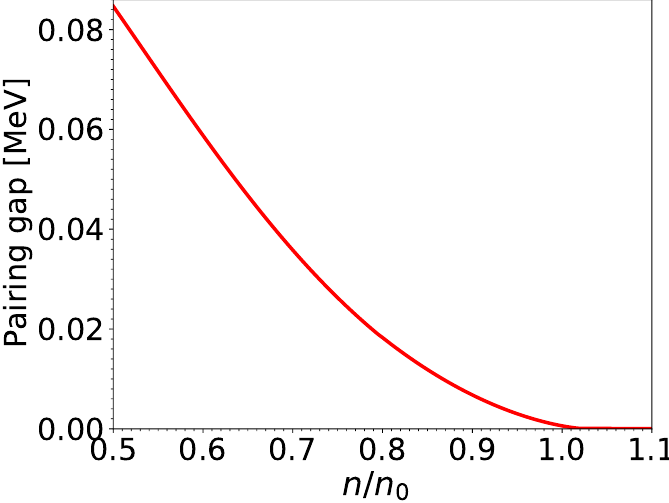
Figure 2. Same as Figure 1 for 1 S 0 proton pairing